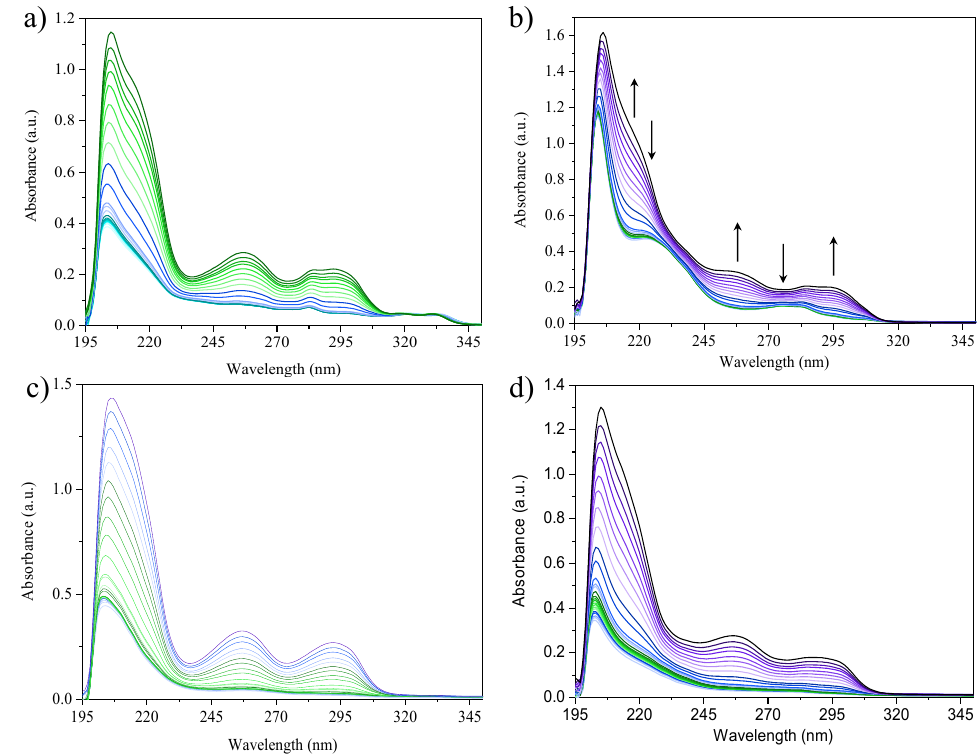
Figure 8. Additive UV-Vis spectra of complexes ( a ) 1 ; ( b ) 2 ; ( c ) 3 and ( d ) 4 performed in a concentration range from 1 × 10 − 9 M to 1 × 10 − 4 M in MeOH as the solvent at 298 K. The arrows indicate the spectral changes upon increasing concentration.